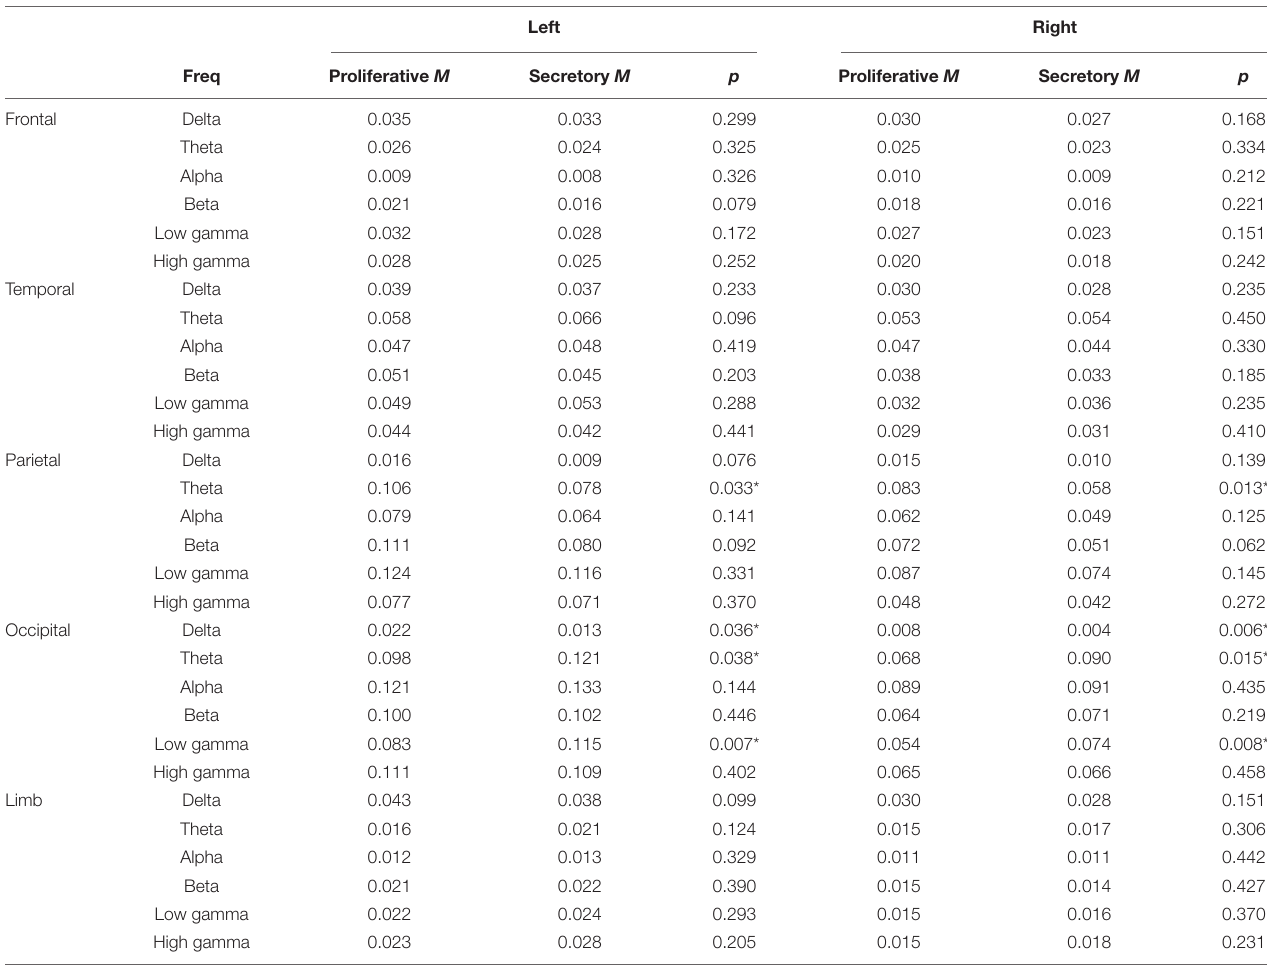
TABLE 3 | Average oscillatory intensity within ROIs and the corresponding statistical differences between the proliferative and secretory phases (Comparison 2 in source-level analysis). Left Right Freq Secretory M